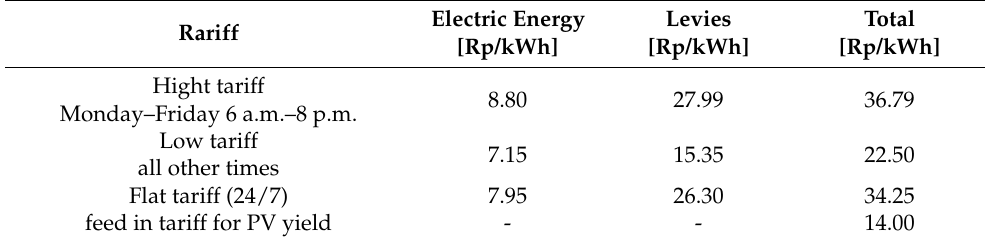
Table 2. Low and high tariff for 2020 incl. tax. [39].